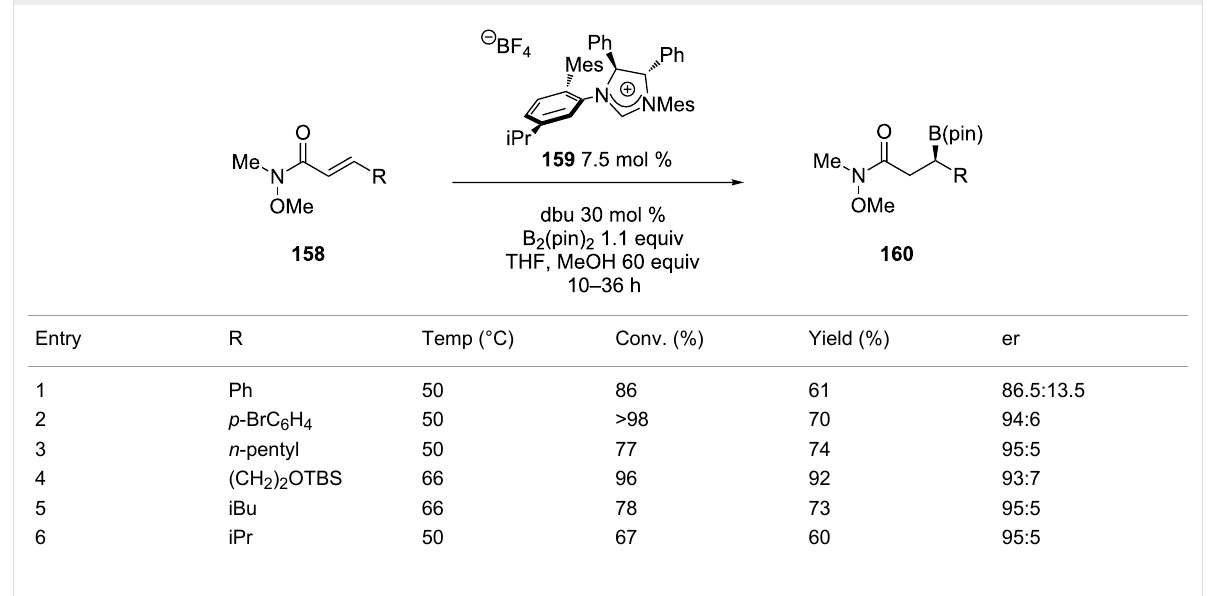
Table 6: Enantioselective 1,4-borylation of α , β -unsaturated Weinreb amides.